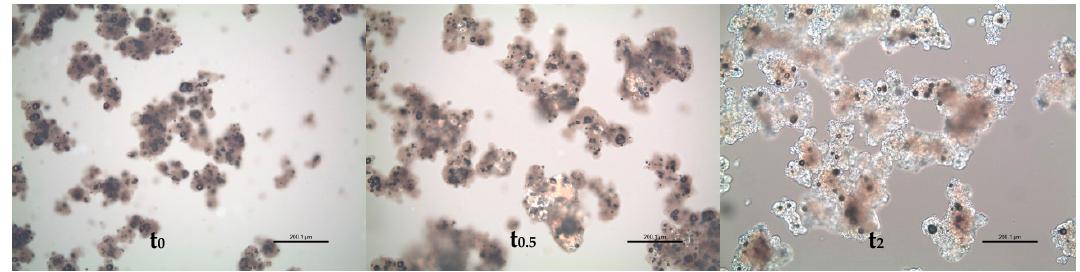
Figure 2. Crystallisation of powder 2 from before exposure ( t 0 ) to ambient conditions and after 0.5 days ( t 0.5 ) and 2 days ( t 2 ) of exposure.